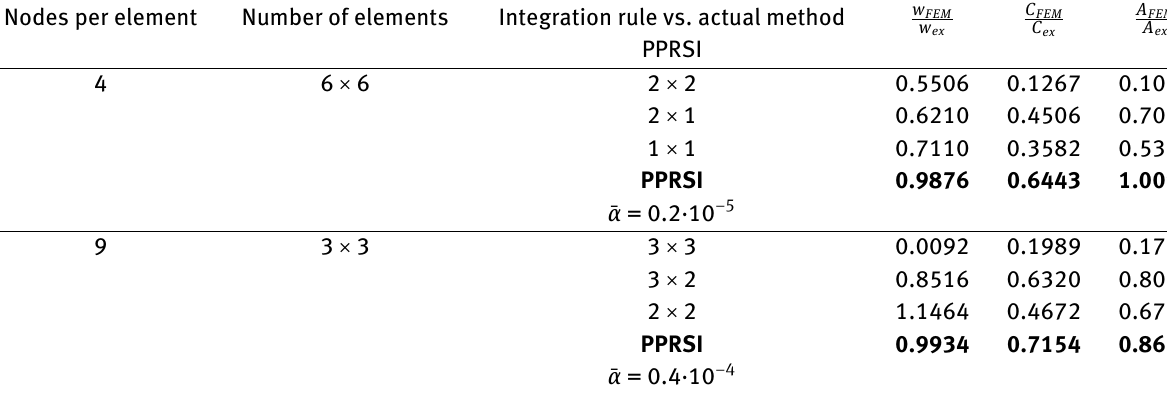
Table 1: Comparison of convergence rates for the FE models, using four and nine-node element Nodes per element Number of elements Integration rule vs. actual method